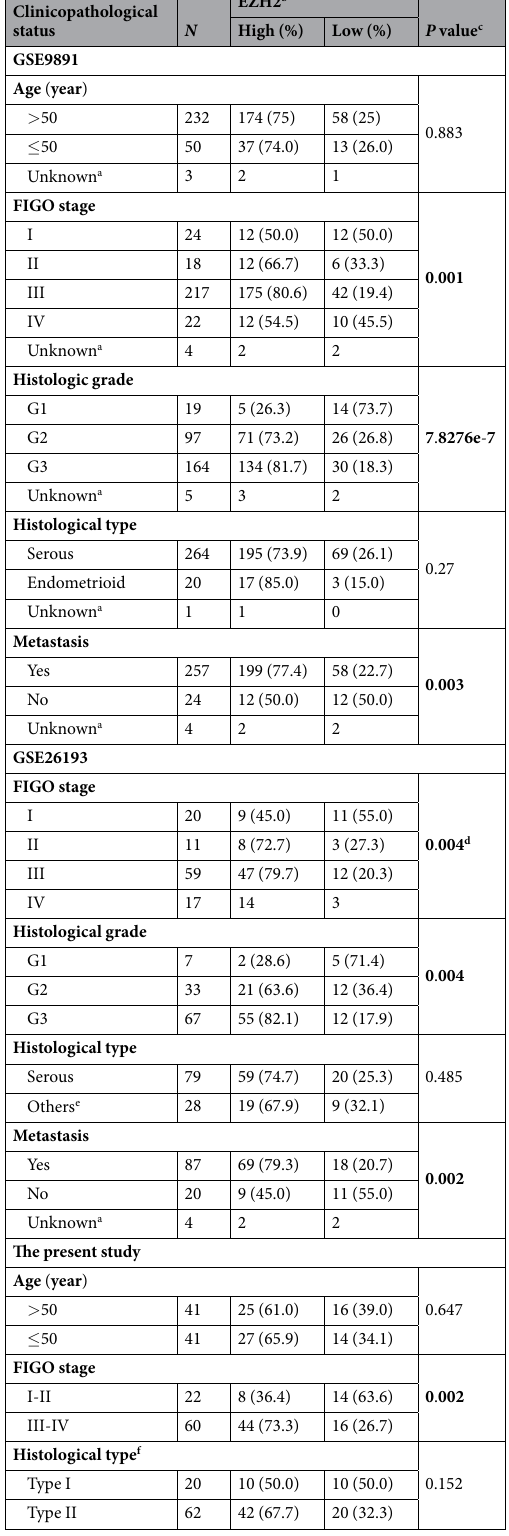
Table 1. Correlation of EZH2 expression with clinicopathological status in ovarian cancer patients. a Statistics did not include the Unknown group. b Cut-off point for EZH2 mRNA from databases was determined by ROC curve. Cut-off point for EZH2 protein was defined as tissues whose positive staining nuclear percentage were greater than 25%. c Chi-square test. d Fisher’s exact tests. e Include mucinous, endometrioid, clear cells, carcinosarcome and brenner tumor. f Type I includes low-grade serous, endometrioid, mucinous, and clear cell tumors; Type II includes high-grade serous tumor. Boldface type indicates significant